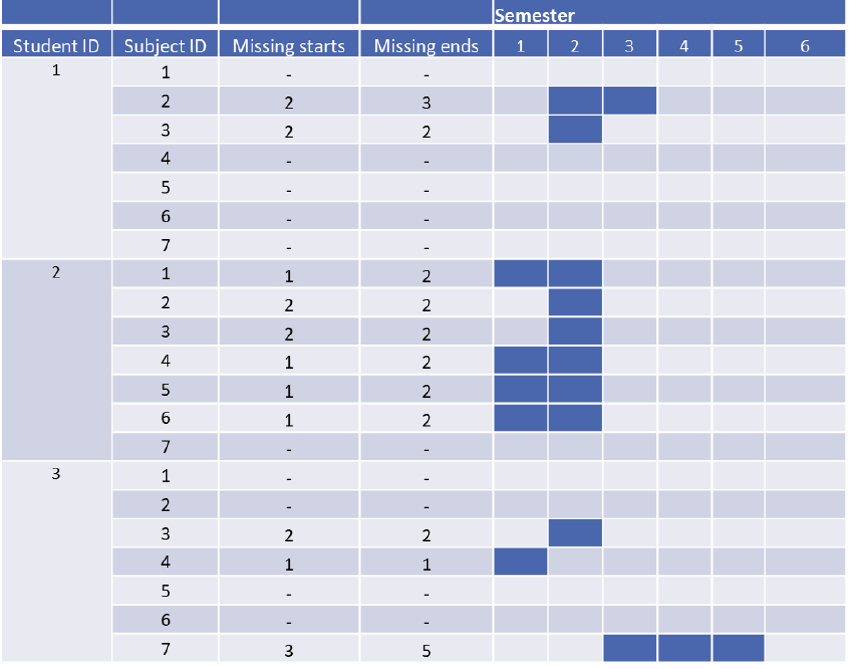
Figure 2. A Gantt chart illustrating the missing subjects of students which have been not performed until it was advised by the sample curriculum. The semesters in which the subject should have been already completed are indicated by dark